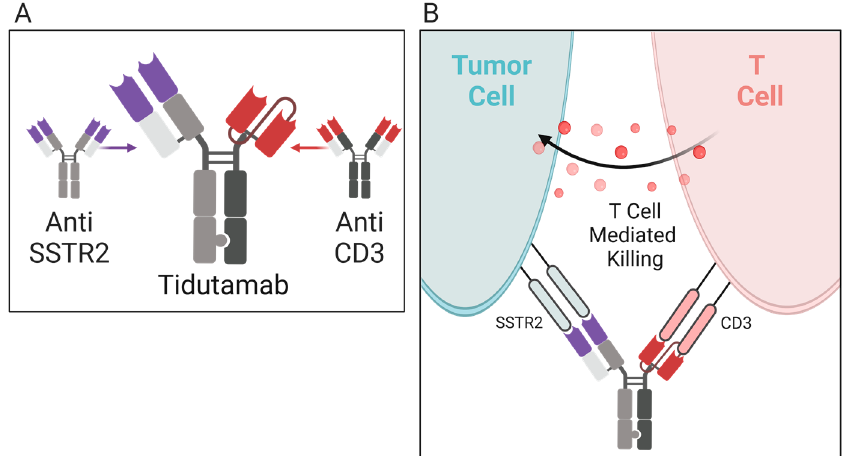
Figure 3. Mechanism of action for tidutamab. ( A ) Tidutamab is a bispecific antibody comprised of anti-somatostatin receptor (anti-SSTR2) and anti-CD3 found on T cells. ( B ) When activated, SSTR and CD3 trigger T-cell-mediated cytotoxicity. The tidutamab antibody combination facilities T-cell-mediated cytotoxicity against carcinoid tumor cells expressing the SSTR2 receptor.